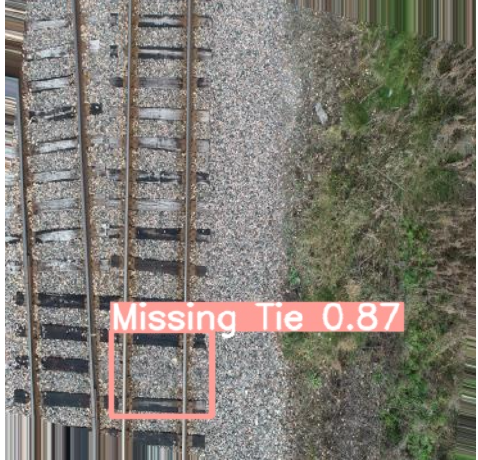
Figure 18. Positive missing tie detection.